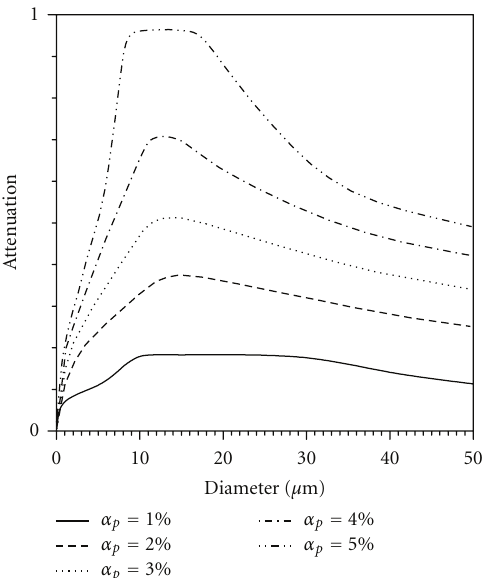
Figure 7: Nondimensional attenuation as function of particle diameter and loading of a single particle set, reference motor, acceleration nullified.